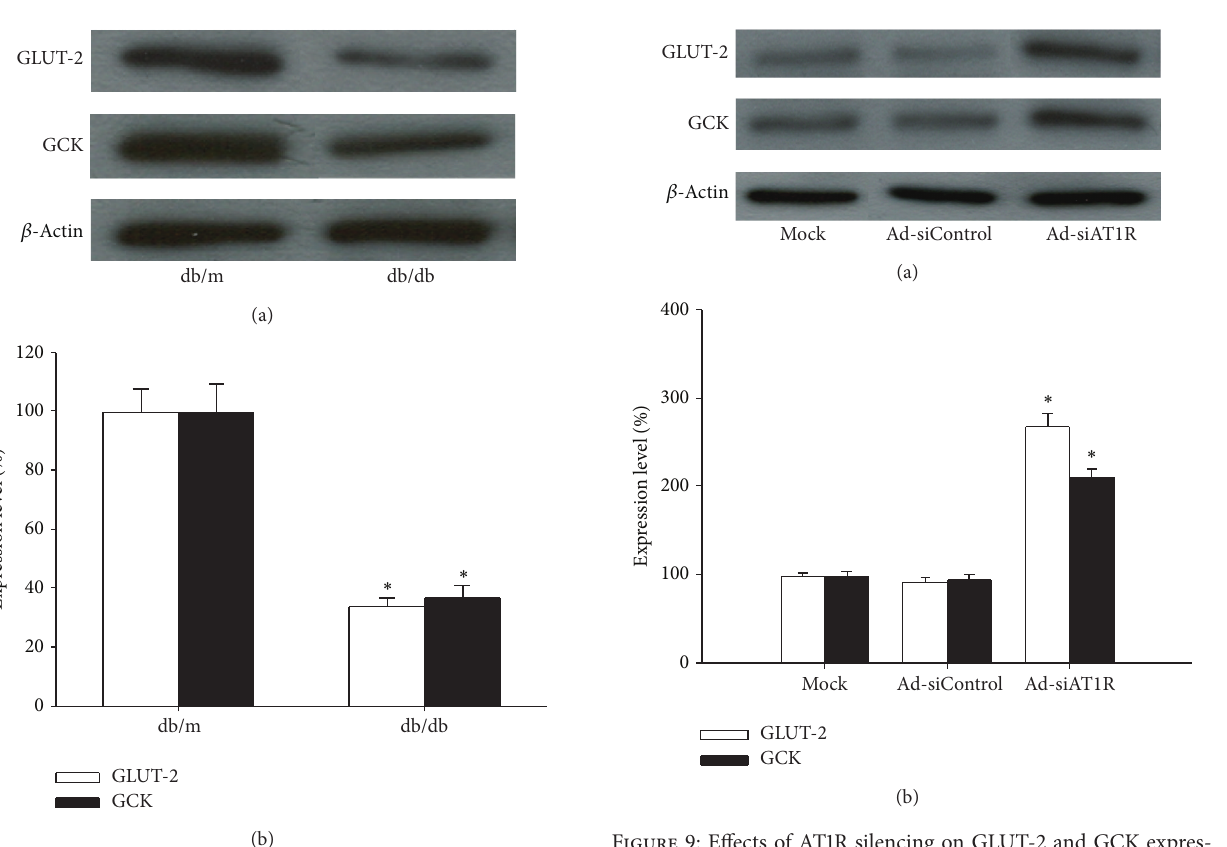
Figure 9: Effects of AT1R silencing on GLUT-2 and GCK expres- sion. Islets of db/db mice were transfected with Ad-si AT1R, Ad- siControl, or Mock and cells were cultured for 72 h prior to immunoblot evaluation of GLUT-2 and GCK. Results are repre- sented as mean ± SD for six independent experiments. ∗ 𝑃 < 0.05 versus